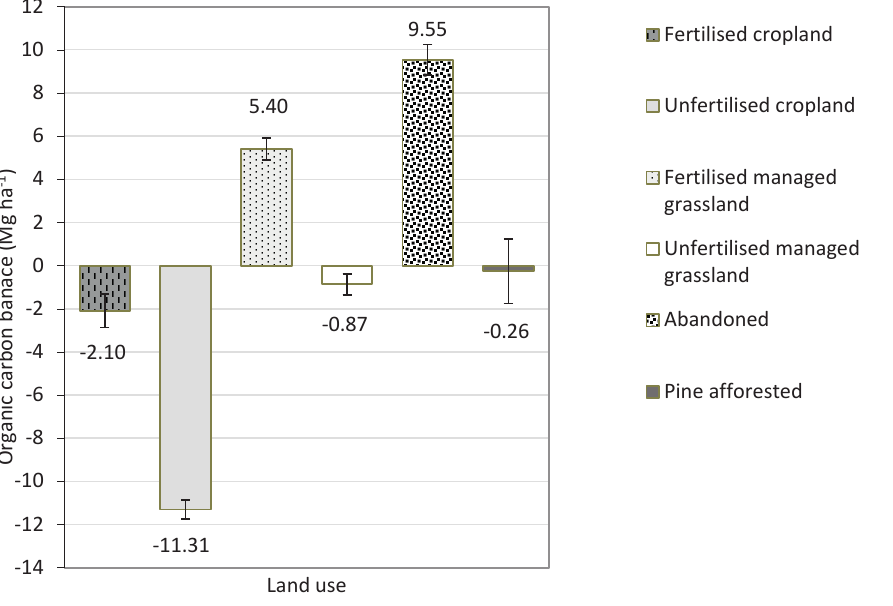
Fig. 2. Changes of organic carbon sequestration (Mg ha -1 ± standard deviation) in soils of different land use during 21